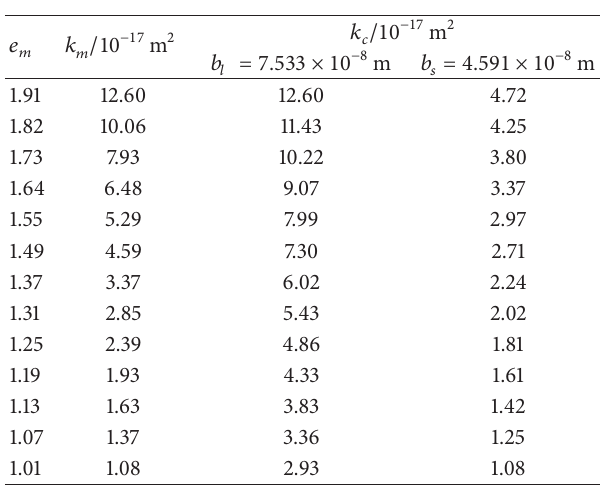
Table 1: Calculated and measured permeabilities of sea clay using the square model.